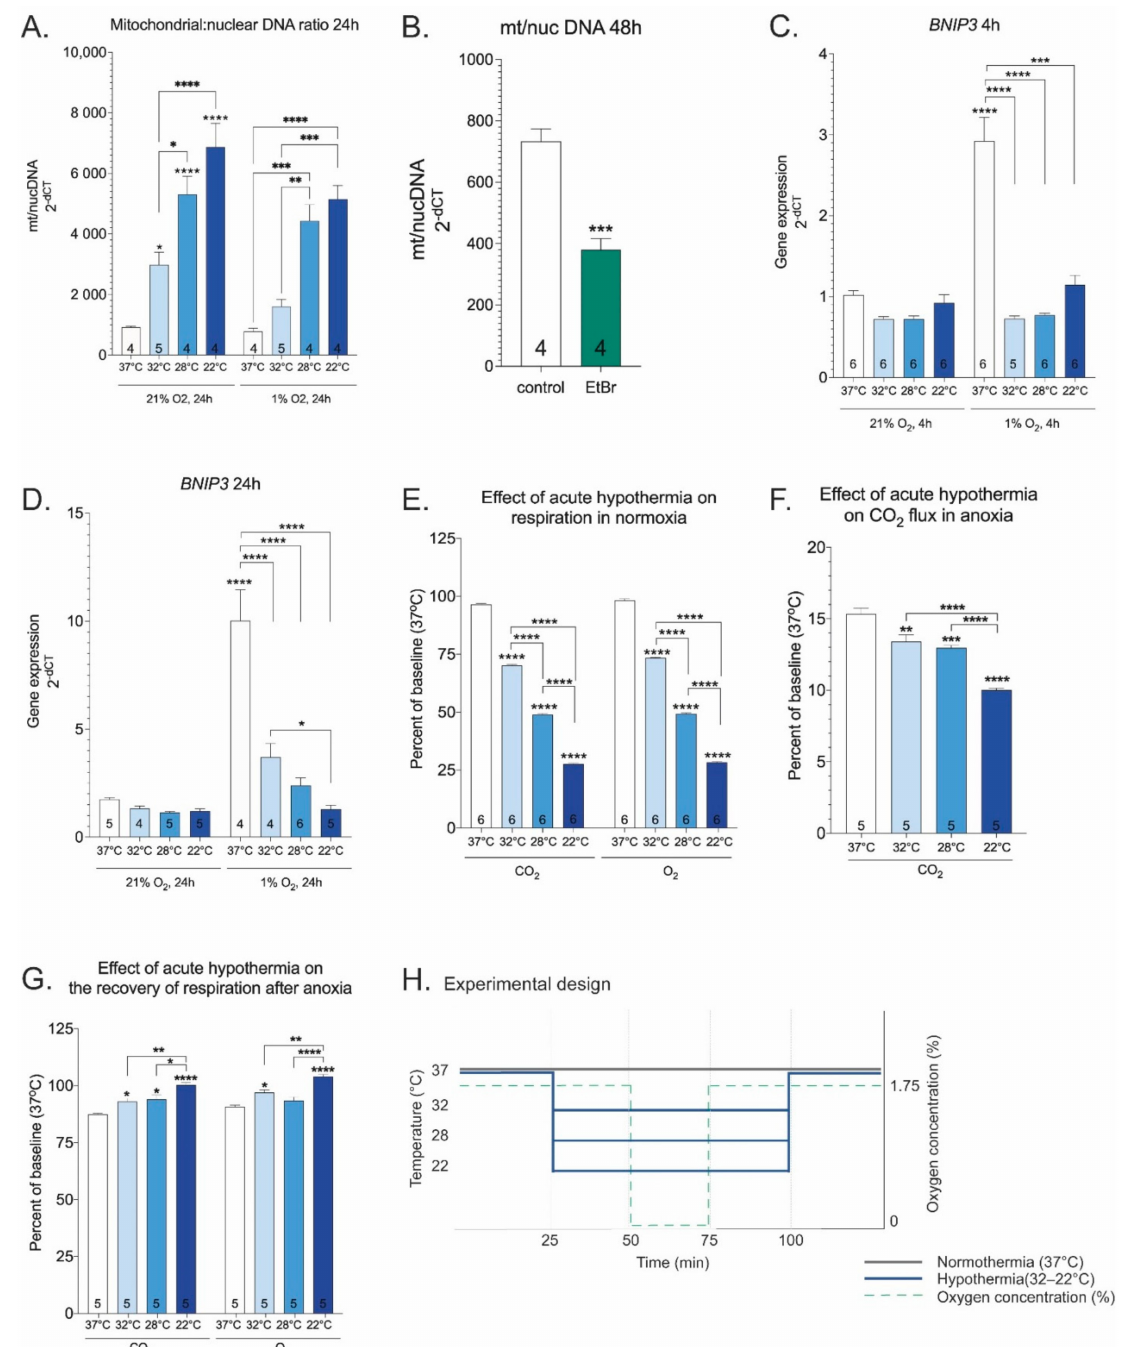
Figure 3. Ratio of mitochondrial DNA to nuclear DNA at various temperatures and oxygen con- centrations at 24 h time point ( A ). EtBr (50 ng/mL, 48 h) was used as a positive control to reduce mitochondrial DNA ( B ). BNIP3 gene expression at various temperatures and oxygen concentrations ( C , D ). Treatments were performed for 4 or 24 h. Effect of acute hypothermia on respiration in nor- moxia ( E ). Effect of acute hypothermia on CO 2 flux in anoxia ( F ). Effect of acute hypothermia on the recovery of respiration after anoxia ( G ). Experiment design ( H ). Asterisks refer to a statistically significant difference with respect to 37 ◦ C control unless indicated otherwise. Numbers in bars indicate sample size. Values are expressed as mean ± SEM. Statistical analysis was performed with One-way ANOVA with post-hoc Tukey HSD Test or unpaired t test with Welch correction ( B ). *, p < 0.05; **, p < 0.01; ***, p < 0.001; ****, p <